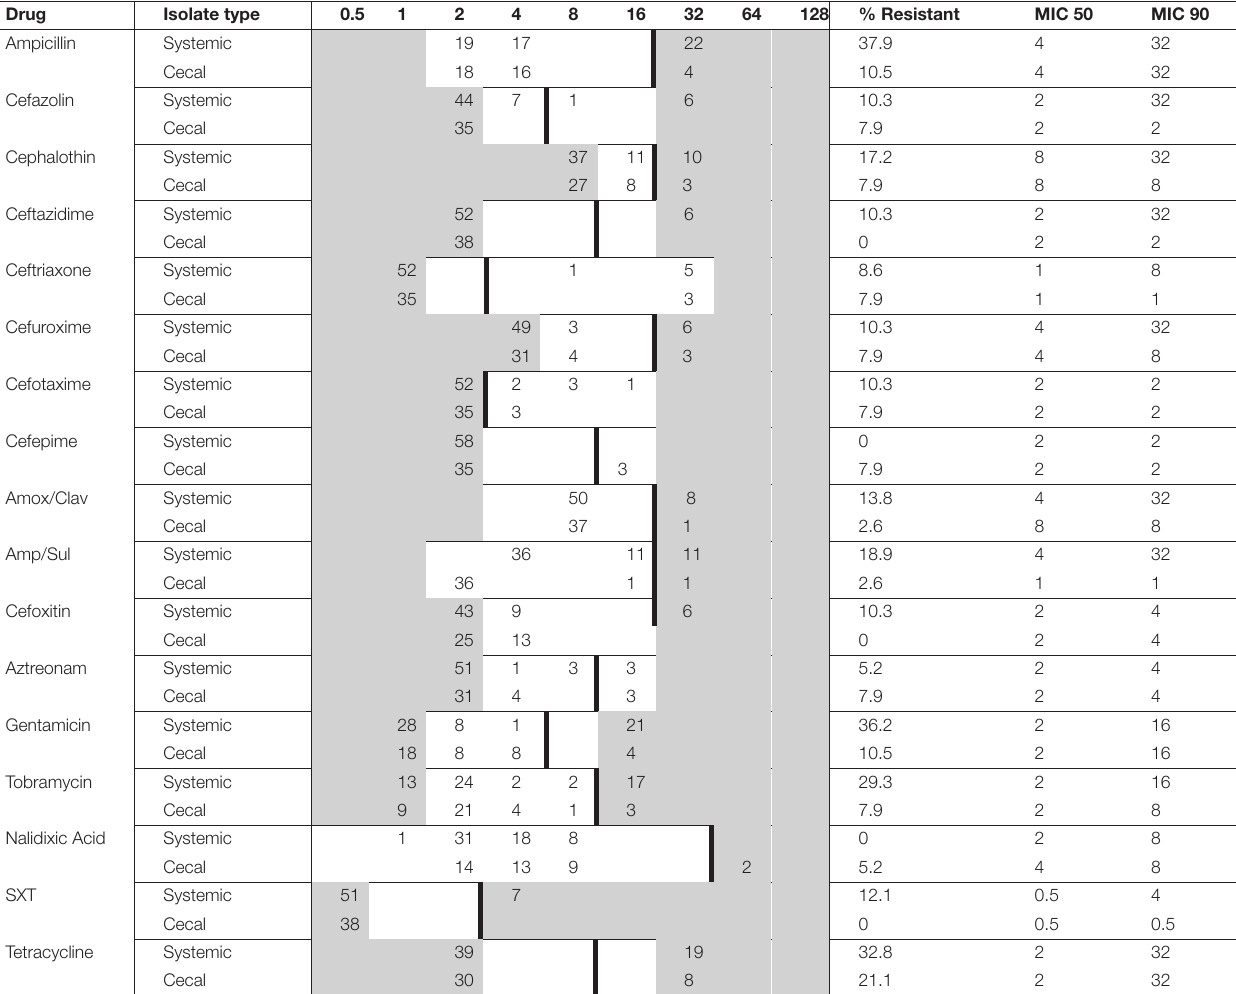
Cells corresponding to concentrations tested are not shaded and resistance breakpoints are marked with dark bars. The number of isolates inhibited at each concentration is noted in each cell. Isolates not inhibited by the highest concentration of each drug are included in the next concentration above the highest tested concentration. (SXT =